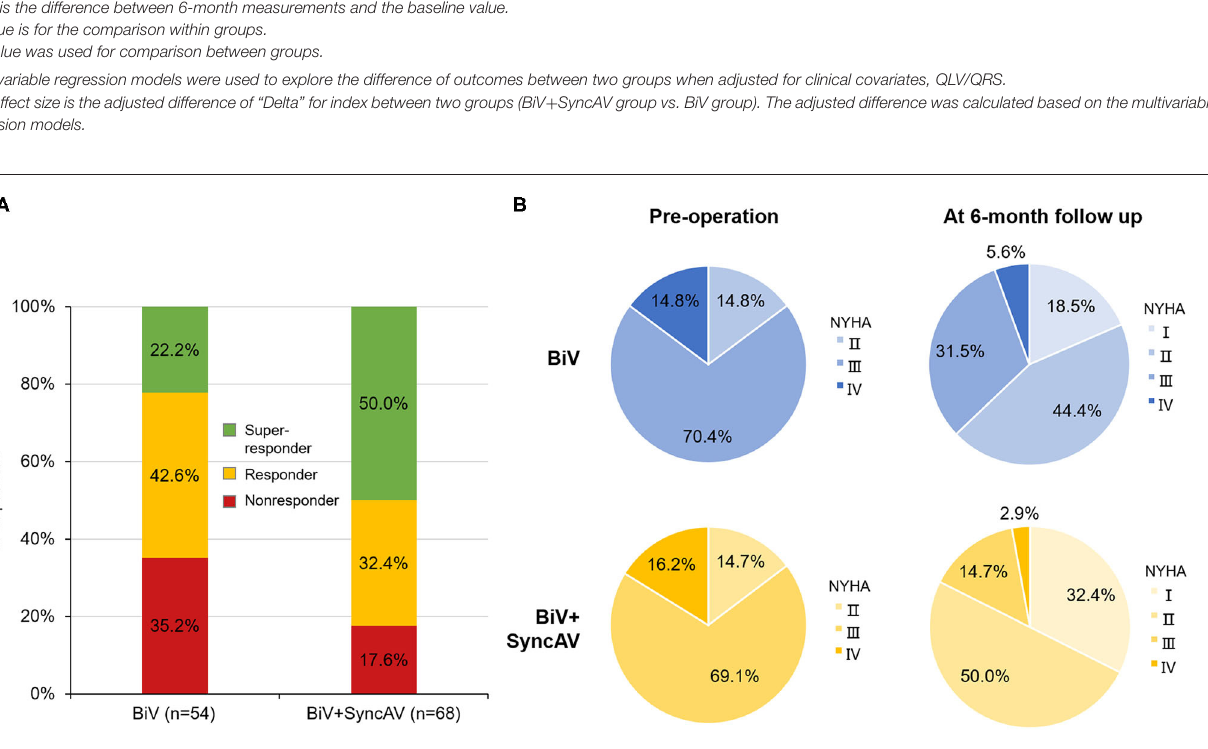
Clinical response, defined as a drop of ≥ 1 NYHA class relative to baseline, was seen in 57 patients (83.82%) in the BiV + SyncAV group compared to 36 in the BiV group (66.67%, P =